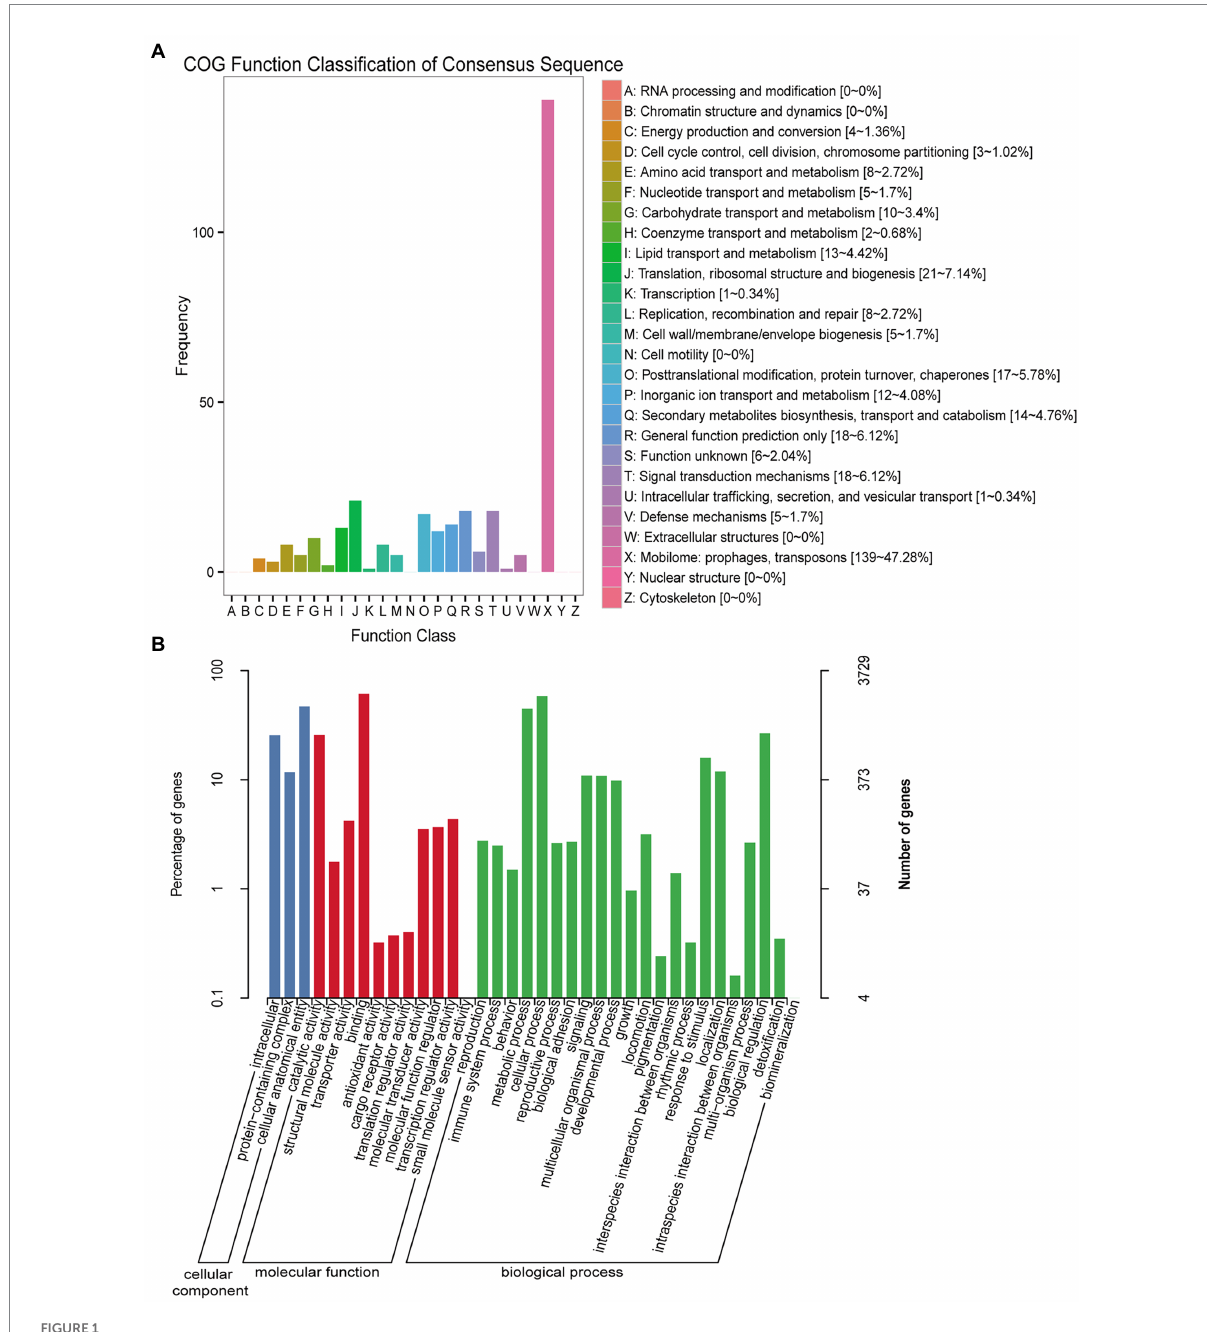
FIGURE 1 COG and GO function classification of unigenes from U-and J-IHNV-infected cells. (A) COG function classification of unigenes. (B) GO function classification of